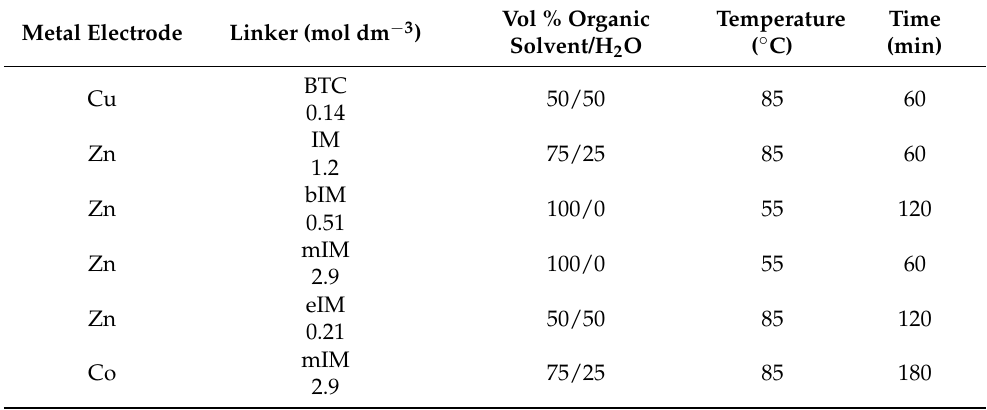
Table 1. Summary of the conditions used to produce a range of MOF coatings using Cyrene TM .